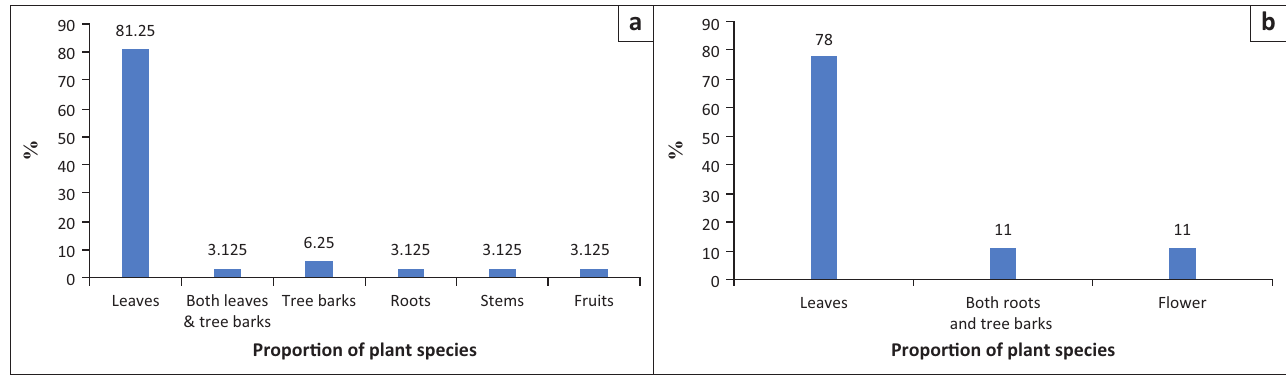
Leaves Both roots and tree barks Propor(cid:27)on of plant